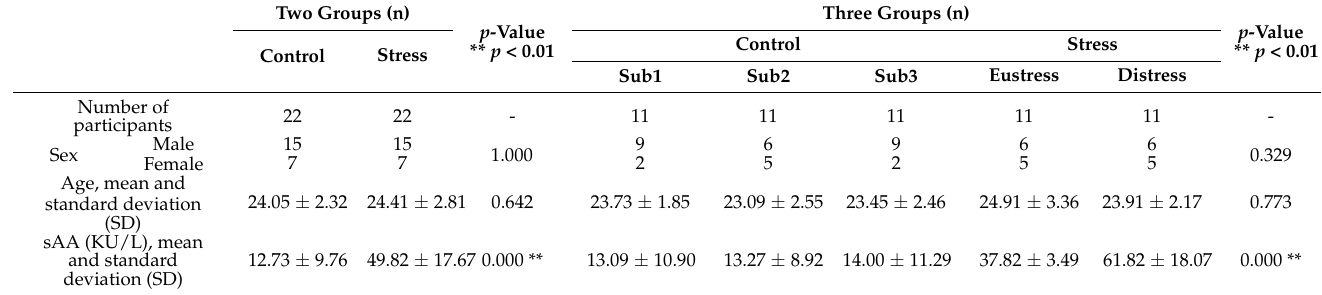
Table 1. Summary of participants between two groups (n = 44) and three groups (n = 33). All groups were selected depending on the saliva alpha-amylase (sAA) levels. To increase statistical significance, the control group shows subsets of random data (n = 11) chosen three times to have a matched number of samples among the three groups. Note that the physiological results of all groups are observed in normal and similar conditions before the experiment. There were no significant differences in sex and age for each group. However, the sAA level shows obvious statistical significance (** p < 0.01). Two Groups (n) p -Value ** p <